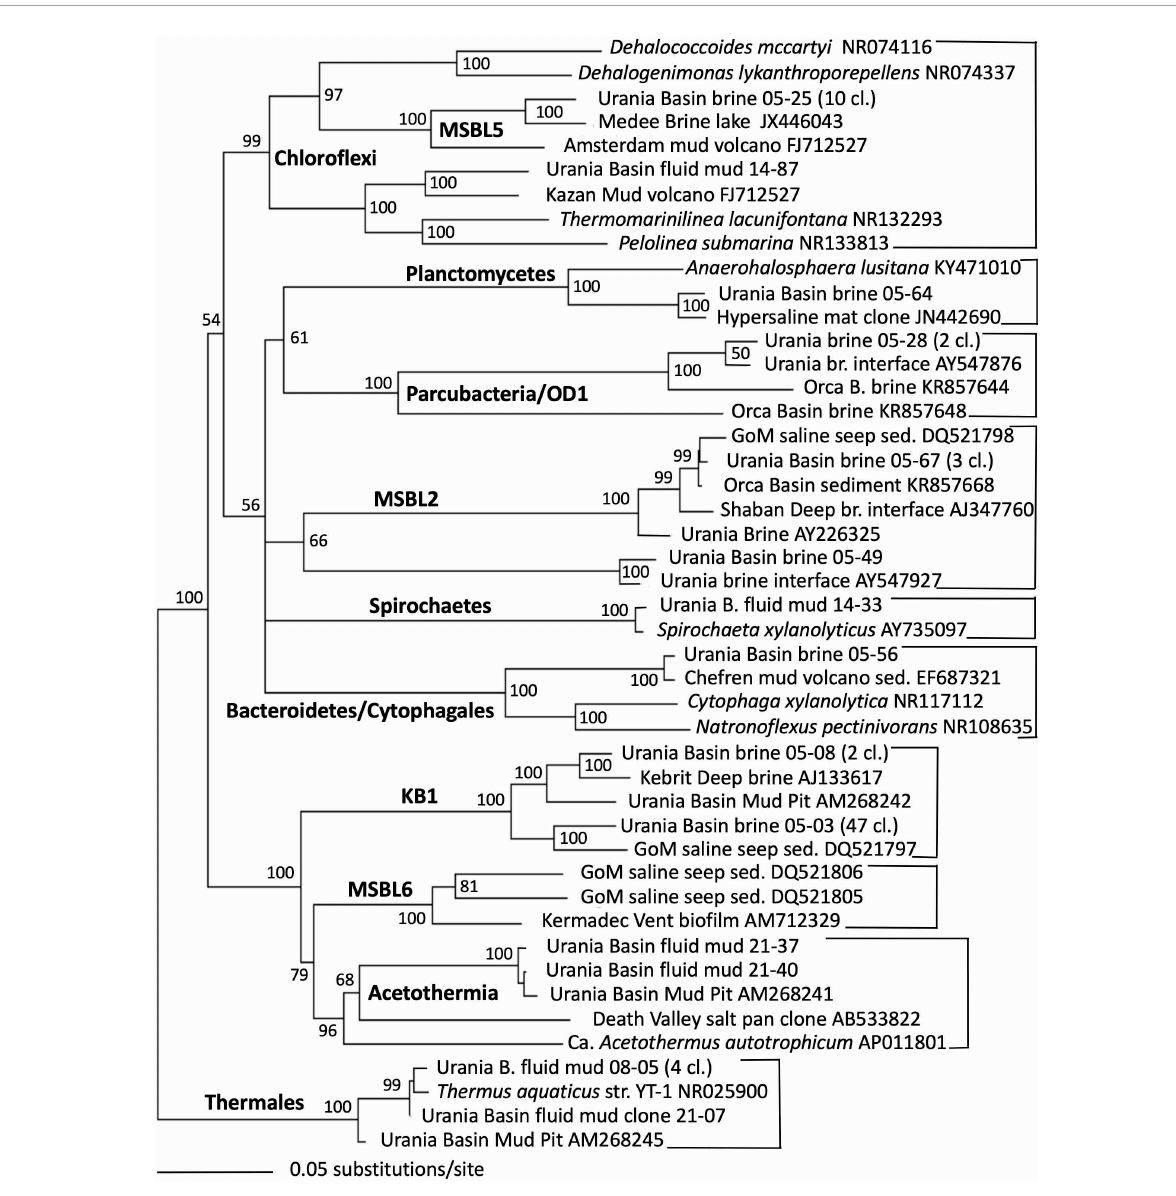
FIGURE3 Phylogeny of general bacteria-affiliated 16S rRNA genes based on distance minimum evolution analysis and 1,000 neighbor-joining bootstrap iterations using PAUP (Swofford,